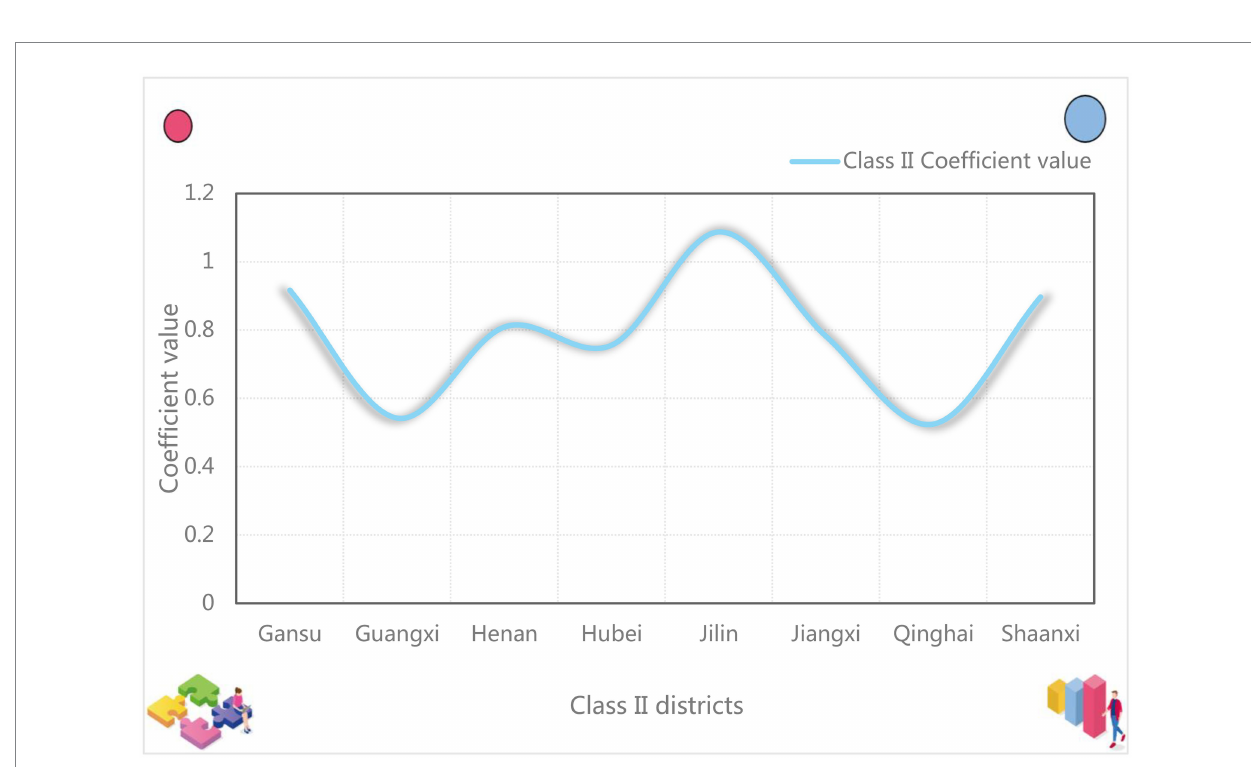
FIGURE 4 Comparison of coefficients in Class II